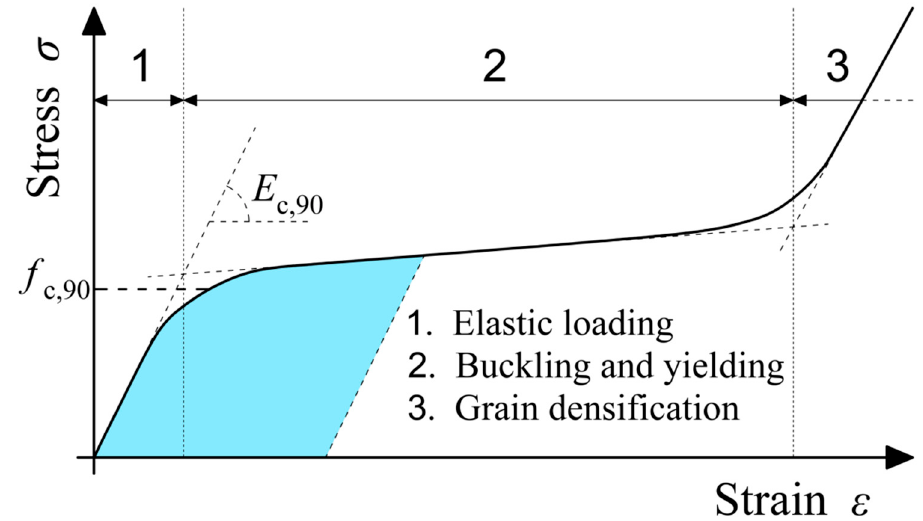
Figure 3. Compressive stress–strain curve perpendicular to the grain of wood, including the respective strength f c ,90 and elastic modulus E c ,90 . Scheme inspired from [21,22].